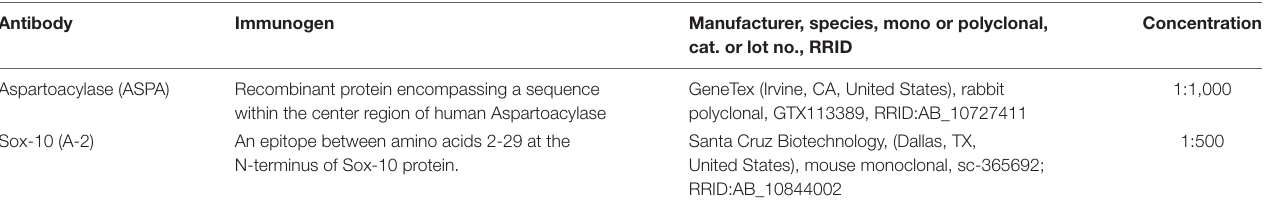
TABLE 1 | Primary antibodies used in immunofluorescence.